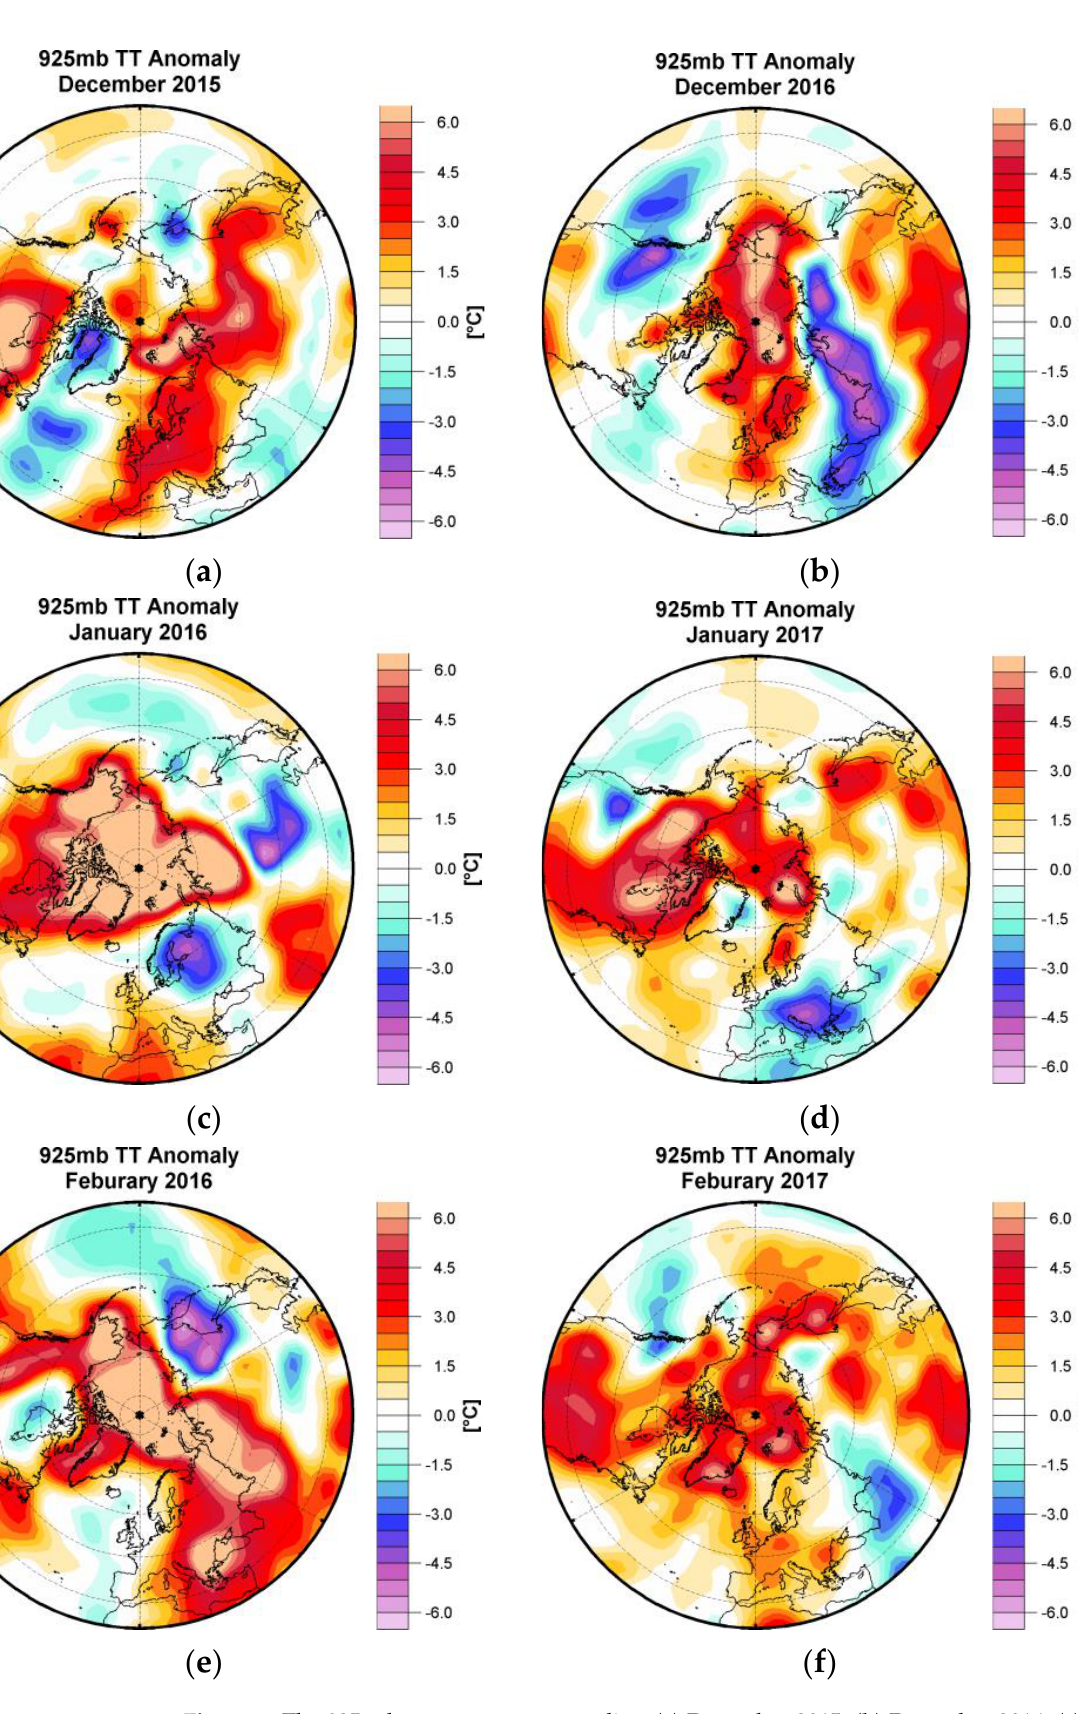
Figure 7. The 925 mb temperature anomalies: ( a ) December 2015; ( b ) December 2016; ( c ) January 2016; ( d ) January 2017; ( e ) February 2016; and ( f ) February 2017.